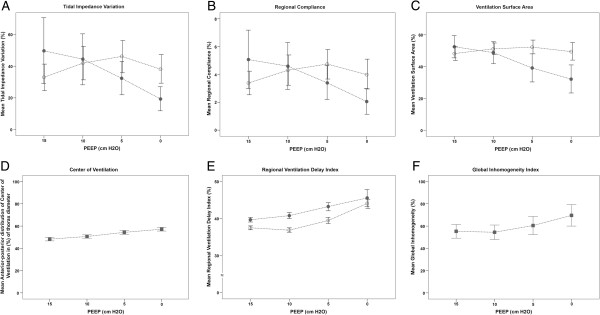
Different electrical impedance tomography (EIT) modalities calculated for the decremental positive end-expiratory pressure (PEEP) trial. Effects of different PEEP levels on regional changes in (A) tidal impedance variation (TIV); (B) regional compliance; (C) ventilation surface area (VSA); (D) center of ventilation (COV); (E) regional ventilation delay (RVD) index; and (F) global inhomogeneity (GI) index. Data are presented as means ± 95% CI. Dashed lines represent the interpolation lines; open circles = non-dependent regions; solid circles = dependent regions; solid squares = entire EIT image.